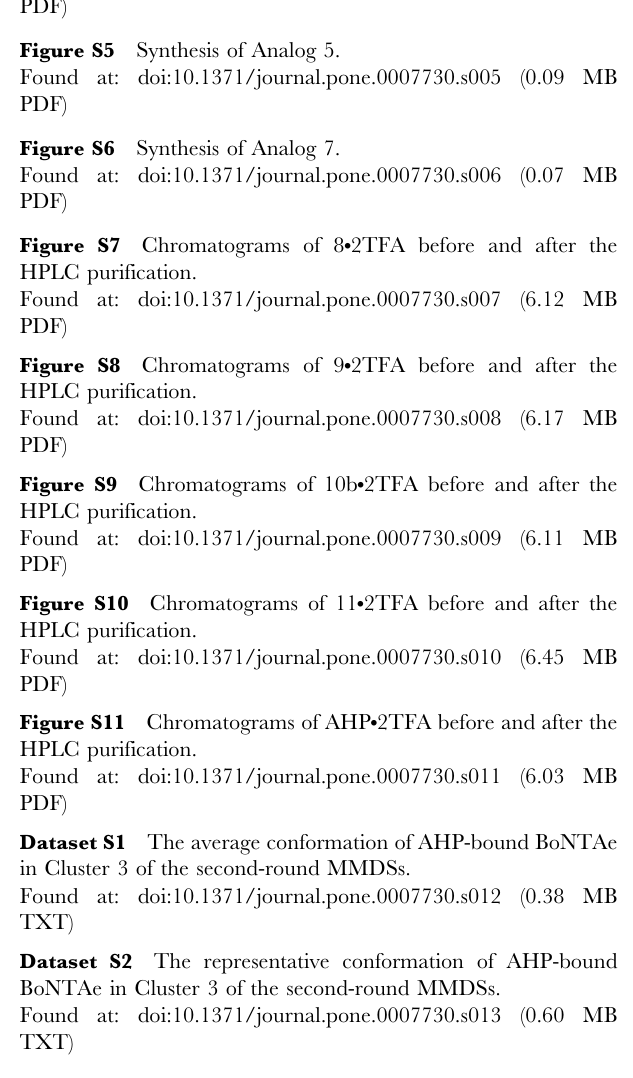
Figure S1 Synthesis toward Analog 2.